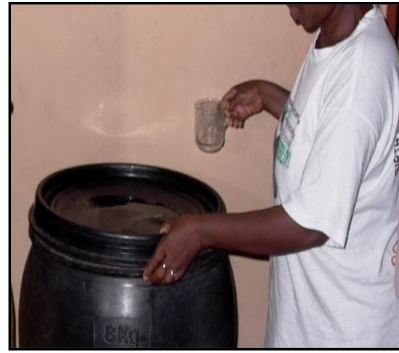
Figure 4. Jug used for water collection.